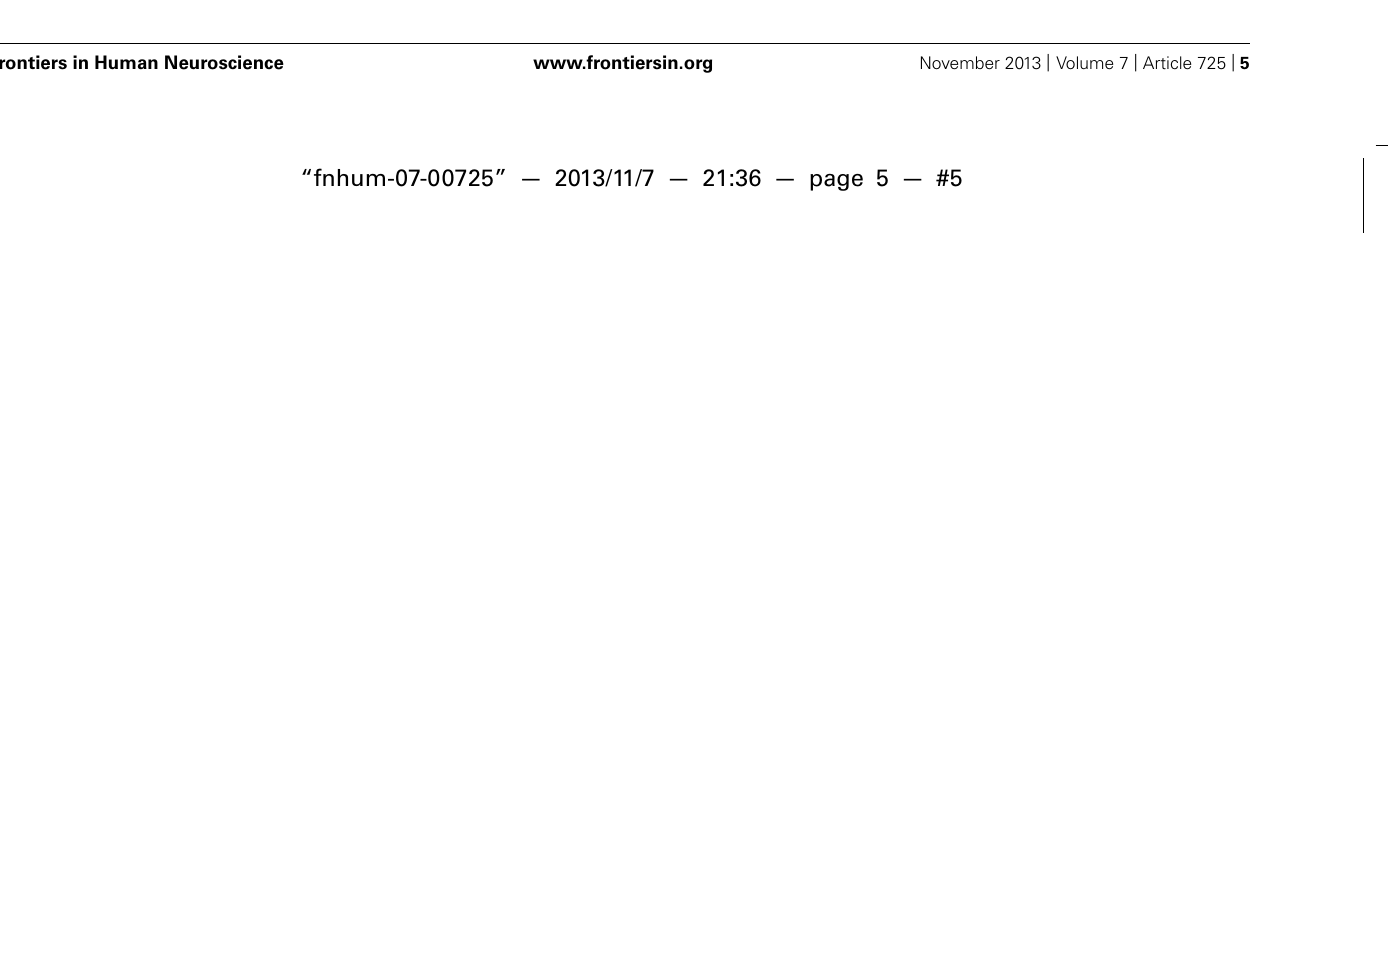
FIGURE 2 | (A) Activity for words ( p < 0. 005, uncorr.) viewed in a passive reading task contrasted against a hash mark (###) baseline, inTD controls (blue) and participants with ASC (red). (B) Direct statistical contrast between groups for words viewed in the passive reading task (FWE p < 0.05). Light blue foci show areas of stronger activation forTD controls as compared to ASC (TD > ASC) participants: the opposite contrast, ASC > TD, was non-significant. (C) Latencies (ms) ofTD controls (blue) and ASC participants (red) who made semantic classifications for action- (diagonal stripes) and object-related (crosshatch) words. Bars show average response times (and standard errors) taken to make semantic decisions.The significant difference between word categories in ASC is reflected by an asterisk ( ∗ ). (D) Significant correlations for ASC participants between activity in the motor system for